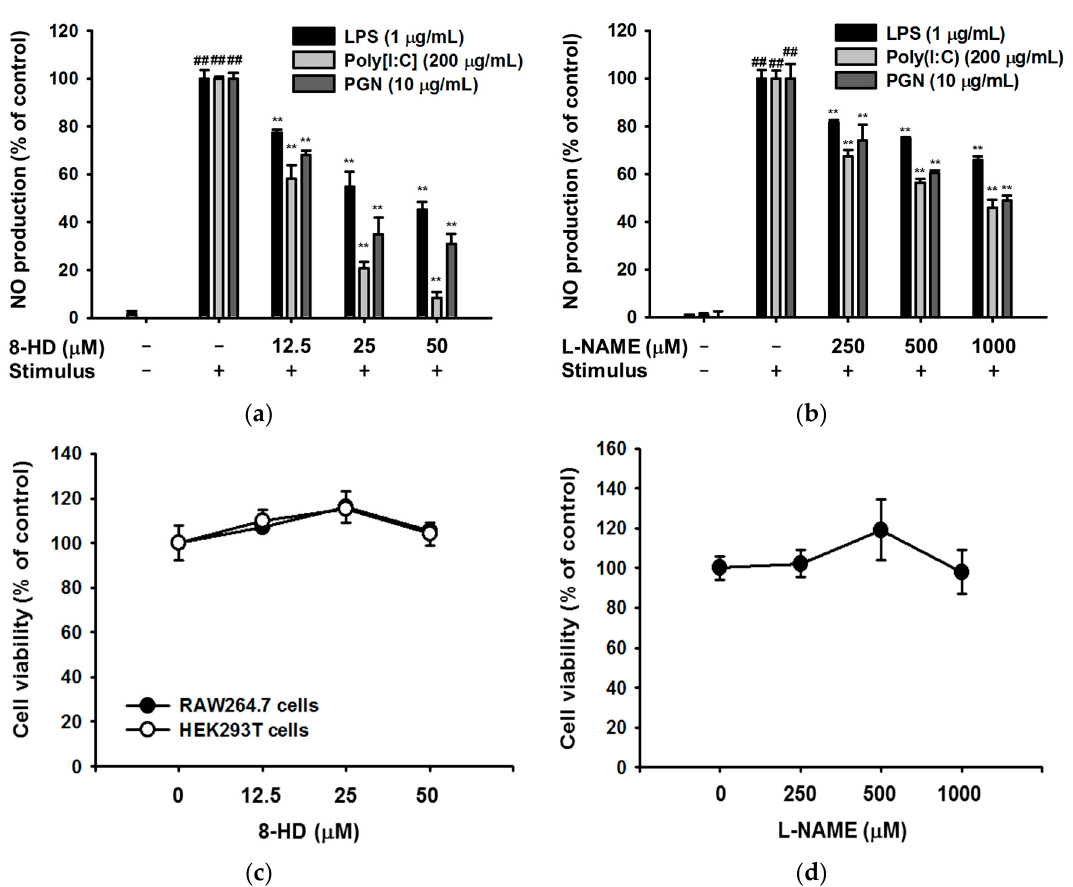
Figure 3. The anti-inflammatory effects of 8-HD. ( a , b ) NO production levels for stimulus-treated RAW264.7 cells were determined by Griess assays. RAW264.7 cells were pre-treated with 8-HD (0–50 μ M) or L-NAME (0–1000 μ M) for 30 min, and cells were then stimulated with Toll-like receptor immunoinducers (lipopolysaccharide (LPS), peptidoglycan (PGN), poly[I:C]) for 24 h. ( c , d ) The cytotoxic effects of 8-HD and L-NAME on RAW264.7 and HEK293T cells were tested by MTT assay. ## p < 0.01 versus a normal group (untreated group), ** p < 0.01 versus a control group (induced group).